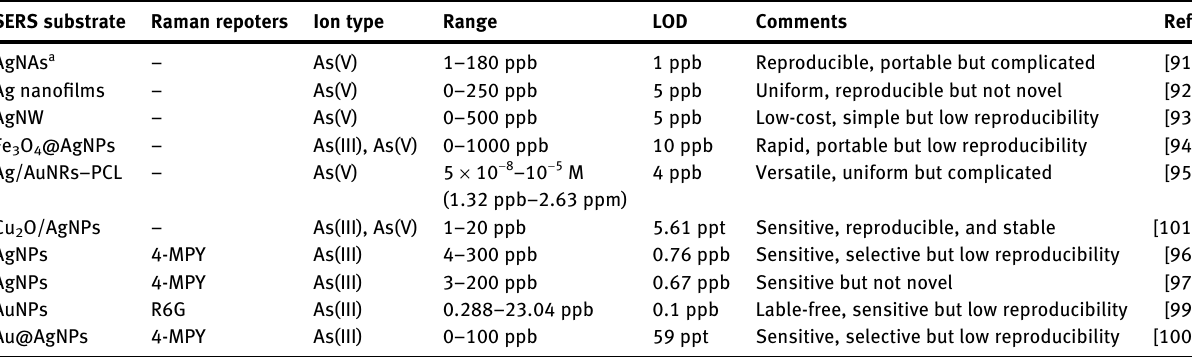
Table  : Strategies for determination of As  + and As  + ions. SERS